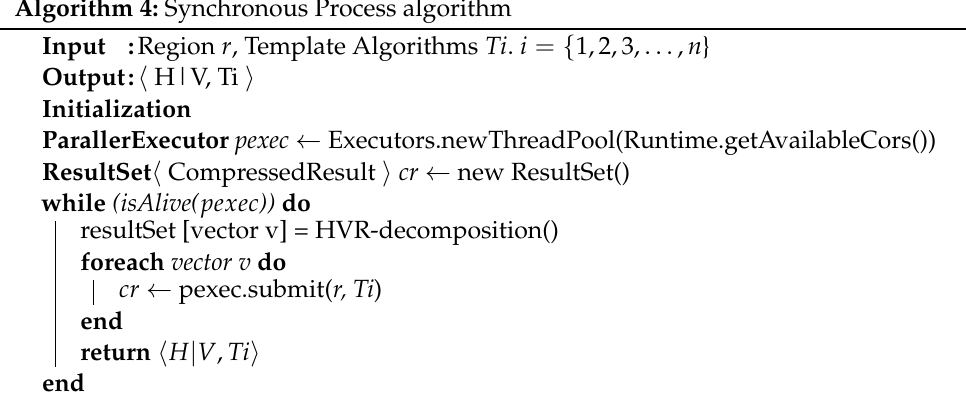
Algorithm 4: Synchronous Process algorithm